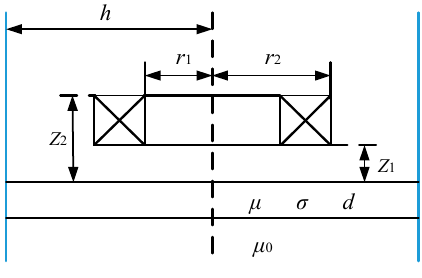
Figure 2. Coil sensor above a plate.